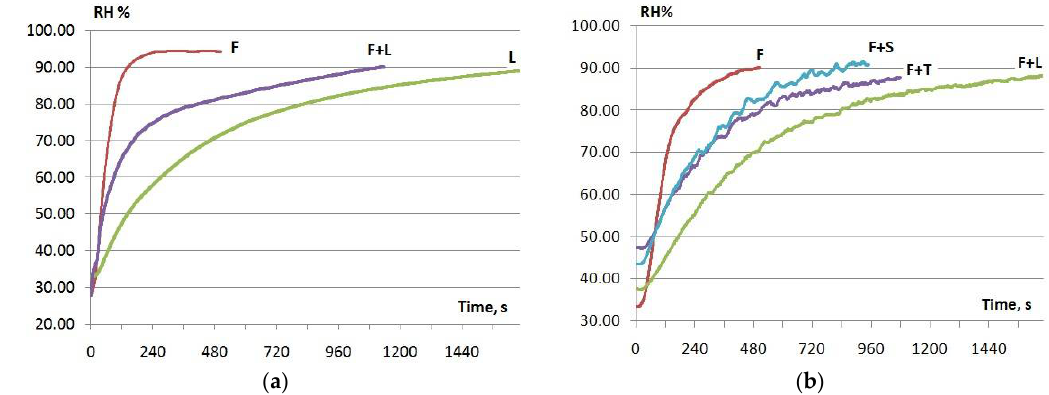
Figure 3. Dynamics of the humidity at the ‘ambient side’ of the different fabric combinations for fixed initial conditions (23 °C and 96% on the ‘body side’ and low humidity air at 11 °C at the ‘ambient side’ for: ( a )-singe membrane-containing fabric, single underwear fabrics and for their combination; ( b )-singe membrane-containing fabric and its combination with three different ‘underwear’